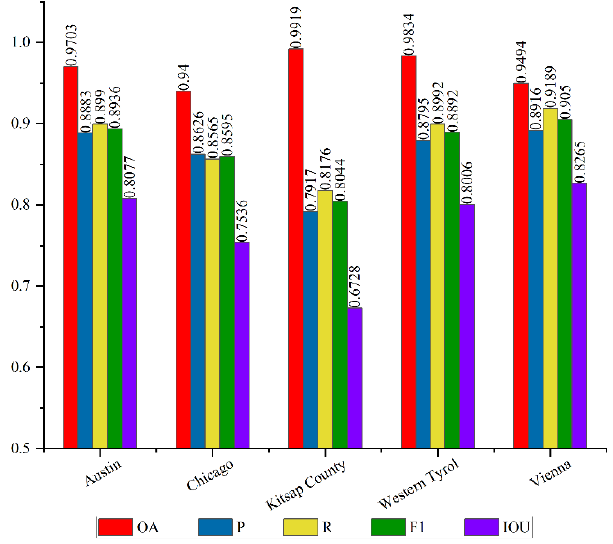
Figure 11. Evaluation results on the Inria Aerial Image Labeling dataset.